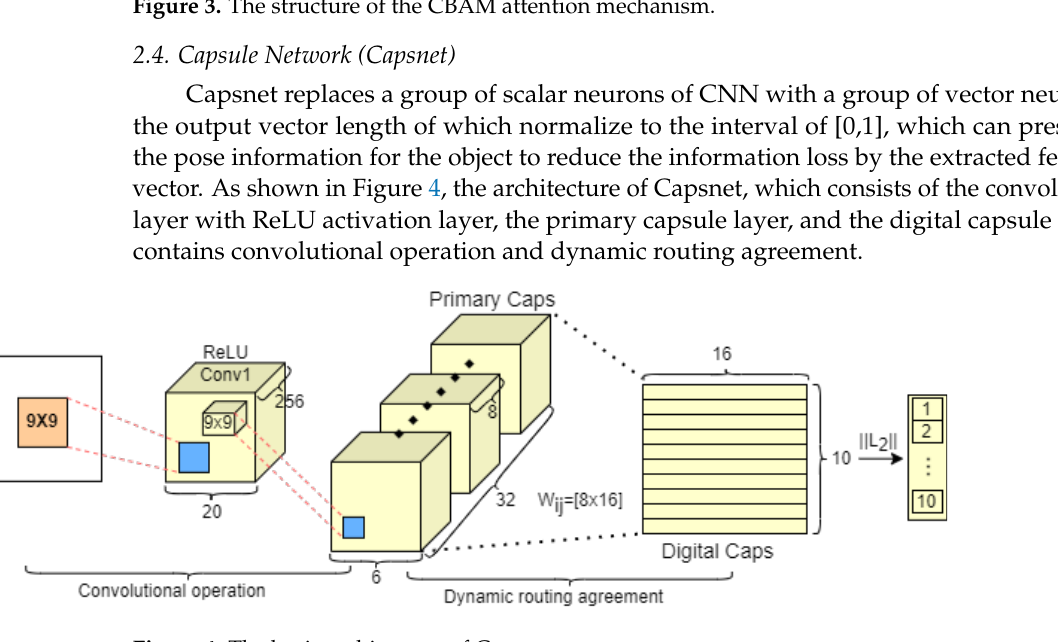
Figure 3. The structure of the CBAM attention mechanism.